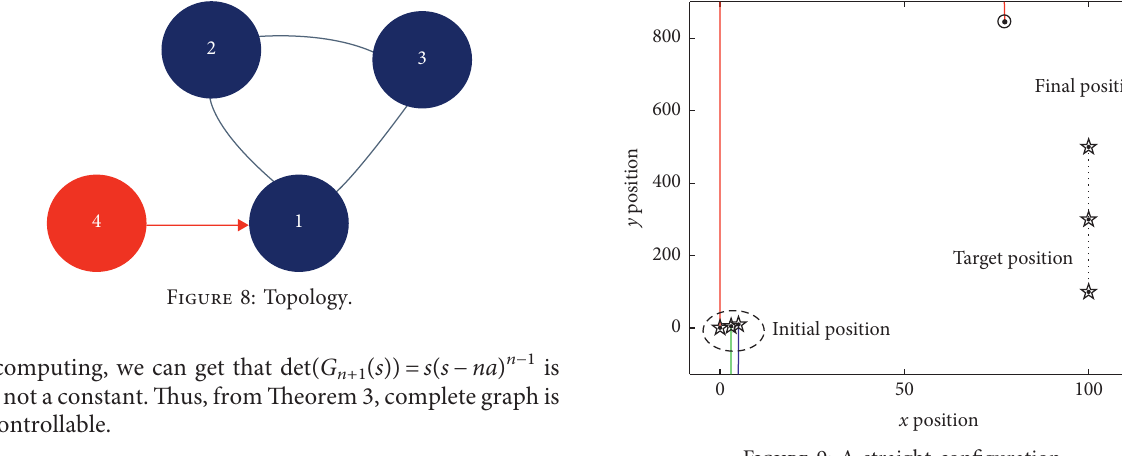
Figure 9: A straight